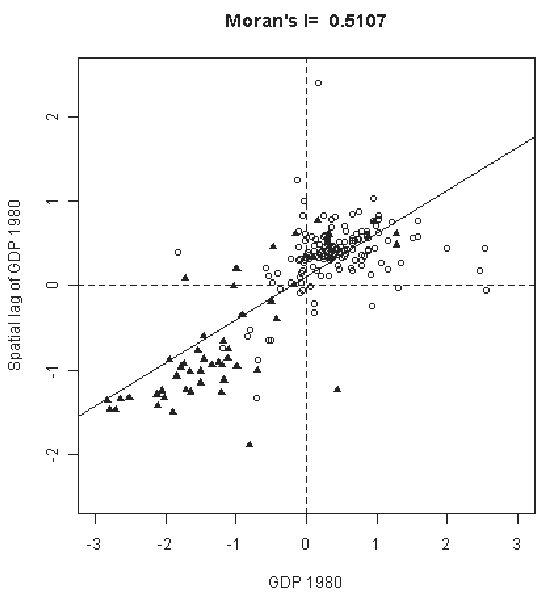
Figure 2 – Moran scatterplot for the logarithm of per-capita GDP in 1980. Objective 1 regions are identified by triangles, non-Objective 1 regions